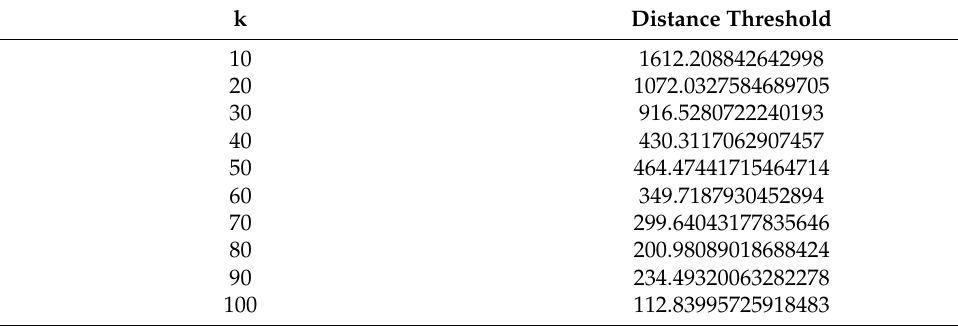
Table 1. Distance thresholds with values for k between 10 and 100.